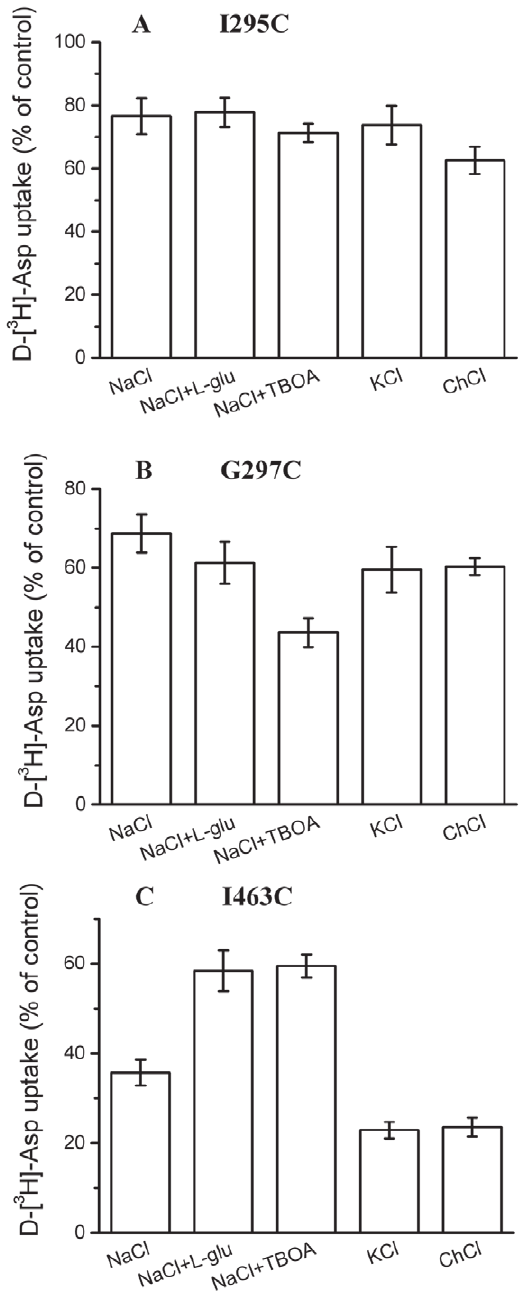
Figure 5. Effect of the composition of the external medium on the inhibition of single cysteine mutants by MTSET. Cells expressing the single cysteine mutants I295C ( A ), G297C ( B ) or I463C ( C ), were preincubated for 5 min in the presence or absence of 1.0 ( A ), 0.6 ( B ) or 0.03 ( C ) mM MTSET. The indicated preincubation solutions contained NaCl, NaCl + 1 mM L-glutamate, NaCl + 20 m M TBOA, KCl, choline chloride. Values are given as percent of control (preincubation without MTSET) and represent the mean 6 S.E. of at least three different experiments done in triplicate.